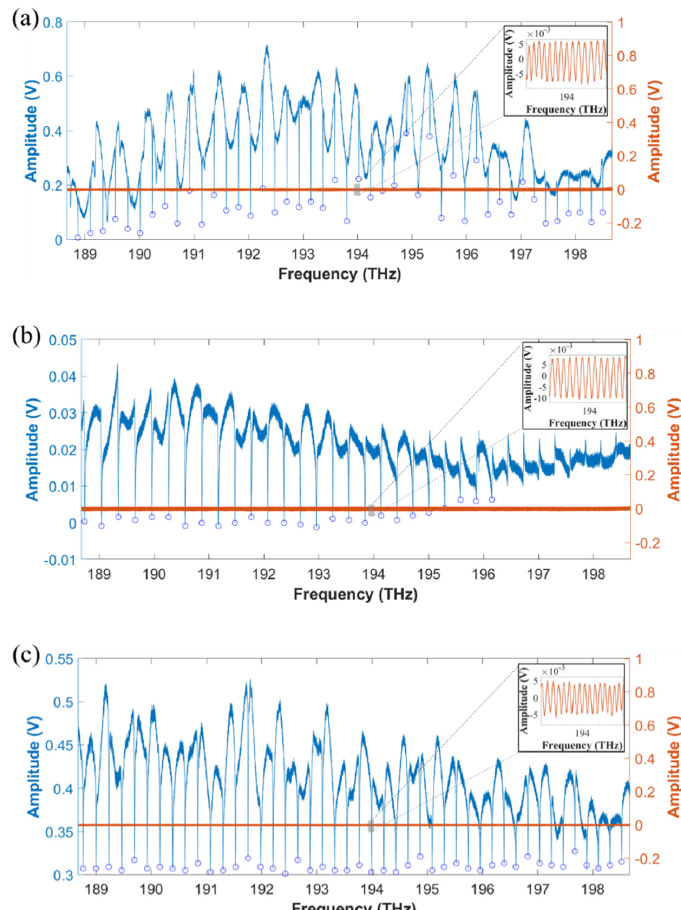
Figure 7. Transmission spectra of the microresonators (blue line) ( a ) without cladding, ( b ) with oxide-cladding, and ( c ) with polymer-cladding. The corresponding interference fringes from the interferometer system are simultaneously recorded for frequency calibration (orange line). The zoom-in spectrum of the interference fringes is shown in the insets.